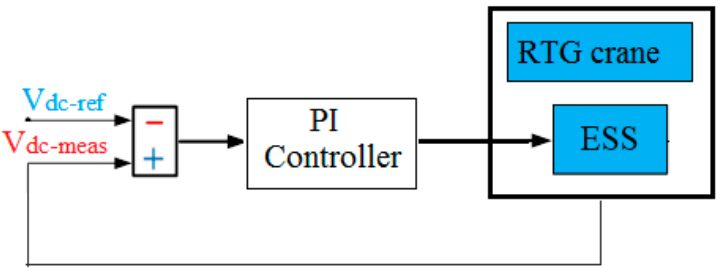
Figure 5. Control loop for the RTG crane system with ESS.